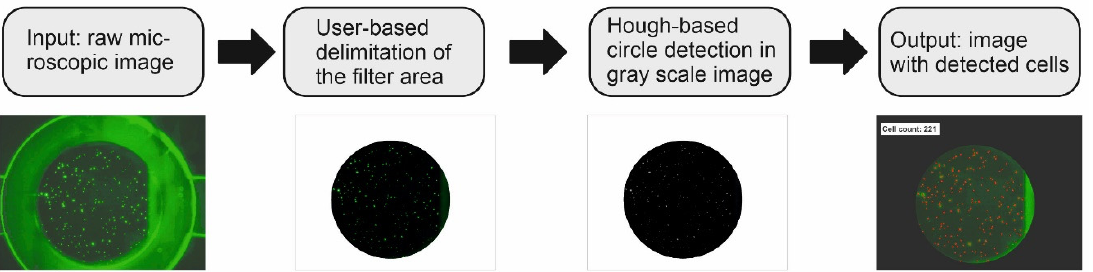
Figure 1. Framework of the digital image processing for cell recognition with circular Hough transform-based algorithm: Step (1) Read in the microscopic fluorescence image; Step (2) User-based determination of the circular filter section. Fluorescent edge regions are cut off to minimize interfering signals in the image for cell detection; and Step (3) Circular Hough gradient transform is applied for cell recognition. Position and radius of every detected cell are stored in an array. Step (4) Generation of output image with detected cell count and positions.